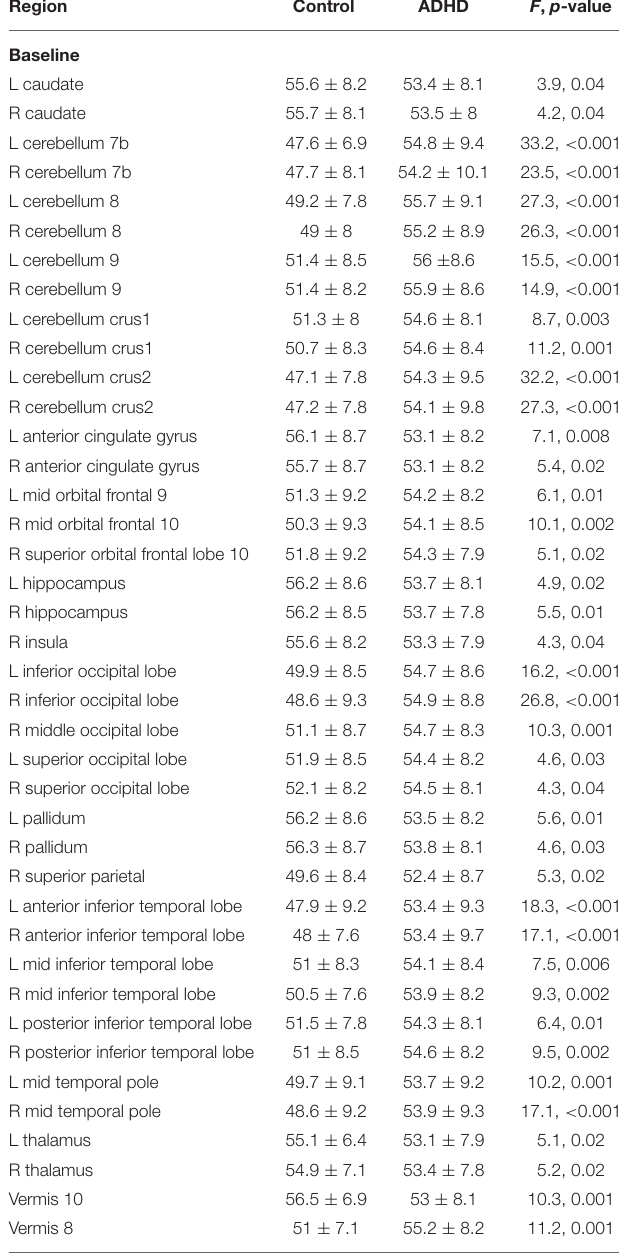
TABLE 3 | Group 1 ROI differences between ADHD and normal.